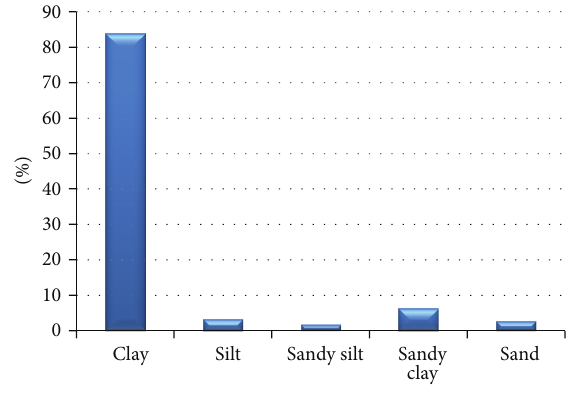
Figure 2: Percentage of loess sediments.